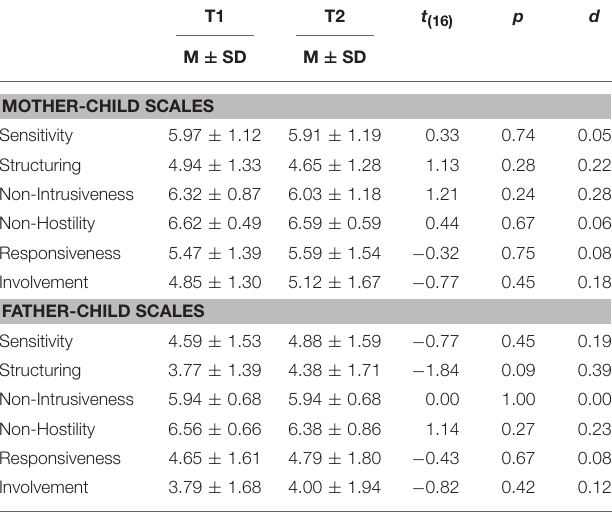
TABLE 3 | Means, SDs of EAS at T1 and T2, and tests for differences. T1 T2 t (16) p d M ± SD M ±